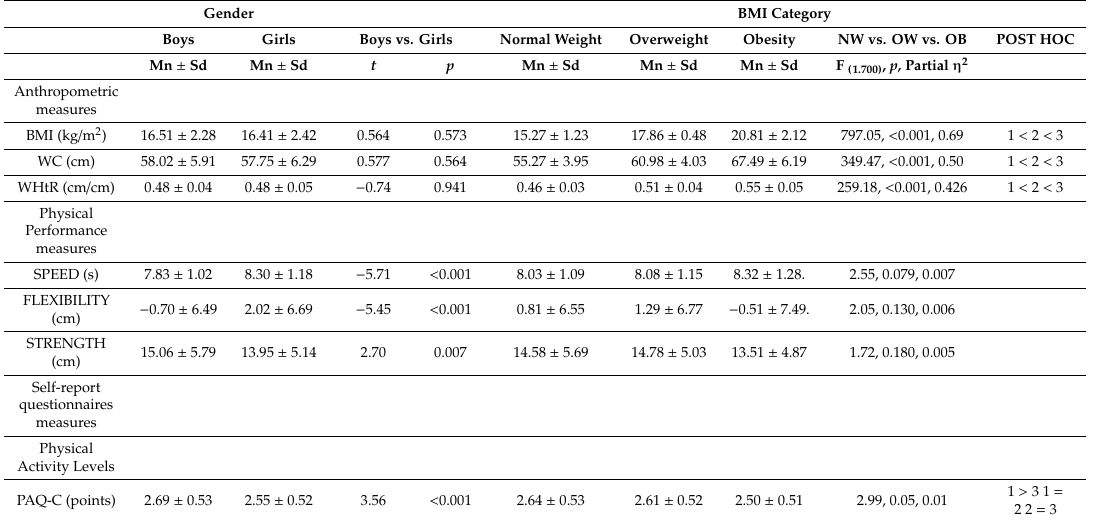
Table 1. Descriptive (Mn ± Sd or %) of all variables analyzed at